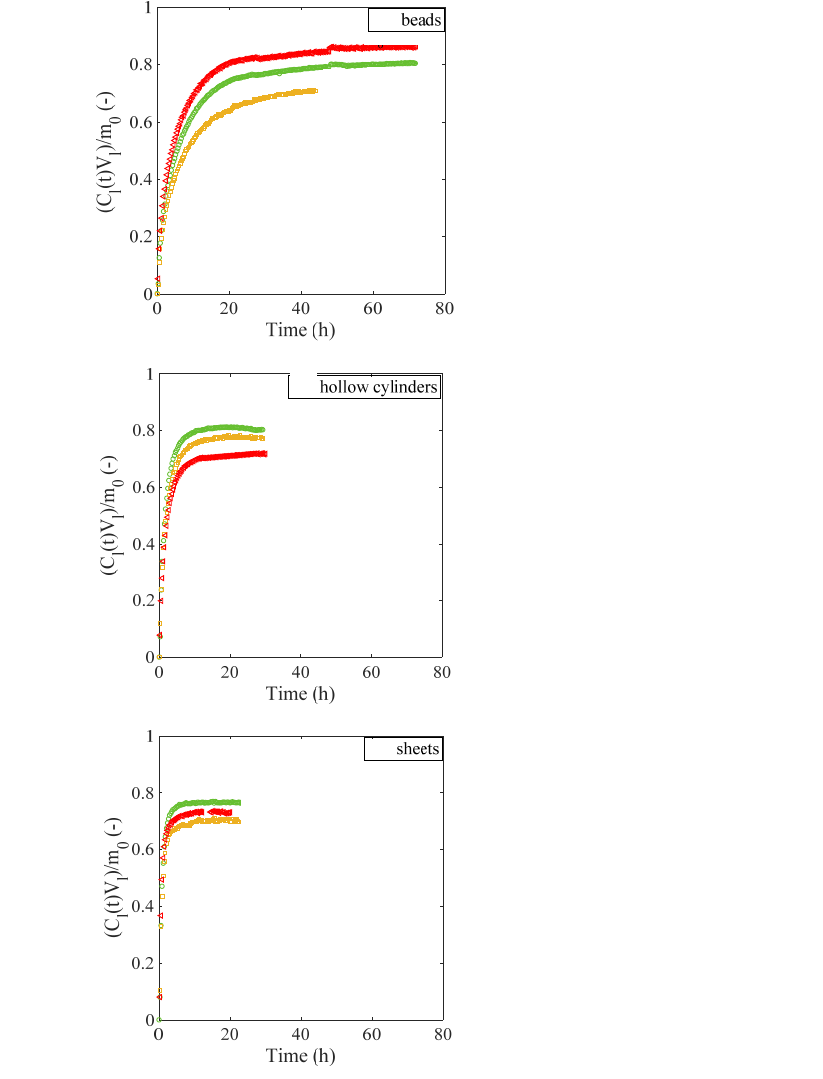
Figure 7. Effect of the hydrodynamics on the normalized amount of Rose Bengal lactone released into the liquid phase for the three different shapes of solid media. ALMBR experiments. In addition, the solid–liquid mass transfer parameters ( 𝑘 (cid:3046)(cid:3039) and 𝑘 (cid:3046)(cid:3039) 𝑆 (cid:3032)(cid:3051)(cid:3030)(cid:3035)(cid:3028)(cid:3041)(cid:3034)(cid:3032) , where 𝑆 (cid:3032)(cid:3051)(cid:3030)(cid:3035)(cid:3028)(cid:3041)(cid:3034)(cid:3032) is the exchange surface between the solid medium and the liquid phase) were